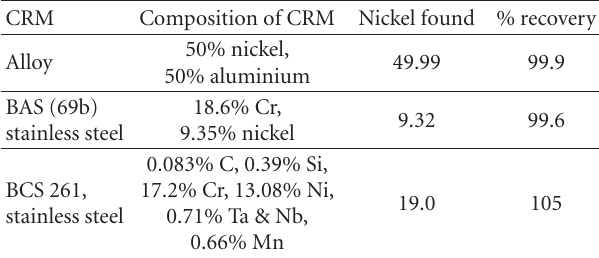
Table 5: Determination of nickel in Certified Reference